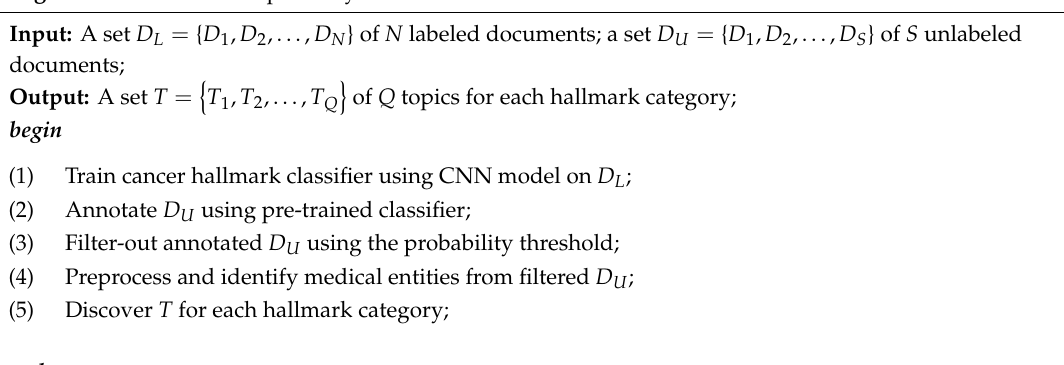
Algorithm 1 Multi-task topic analysis framework